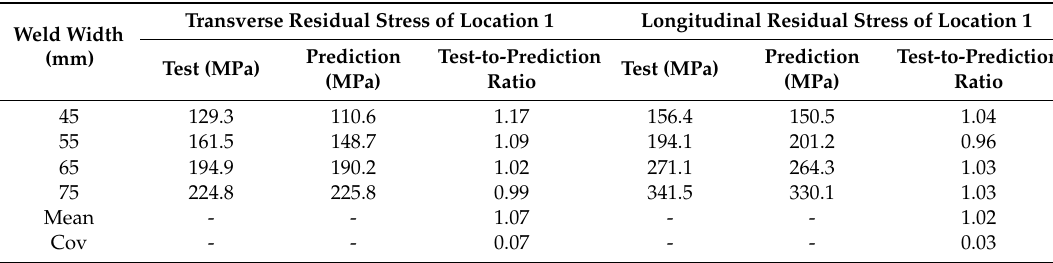
Table 6. Comparison of FEM analysis and experimental results [39].